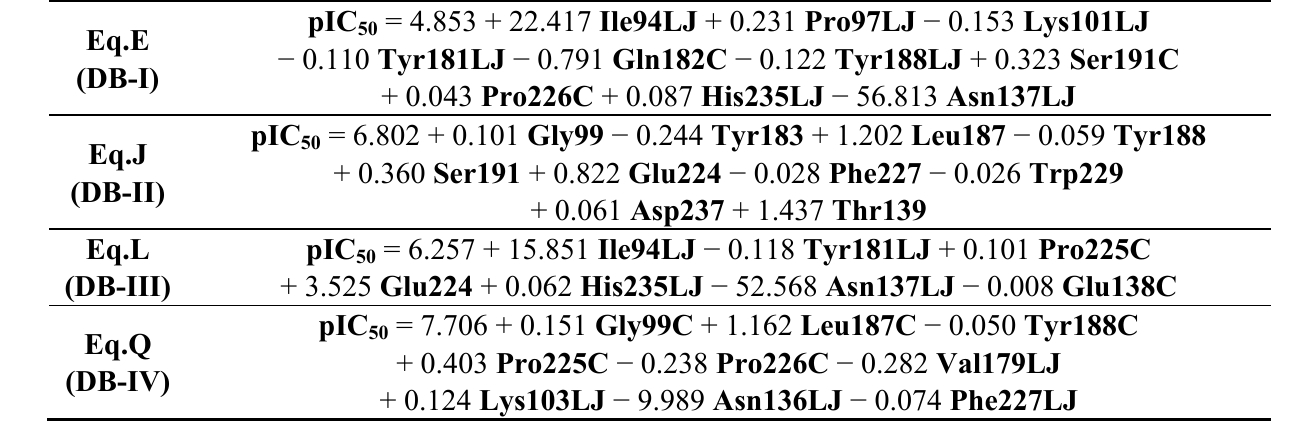
Table 4. Descriptors selected in the best equations of DB-I to DB-IV